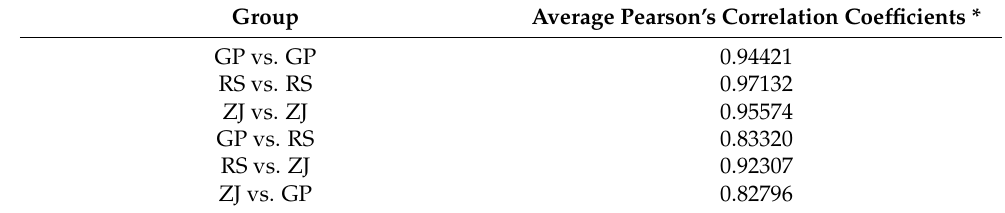
Table 1. Average Pearson’s correlation coefficients for comparisons of intragroup and intergroup